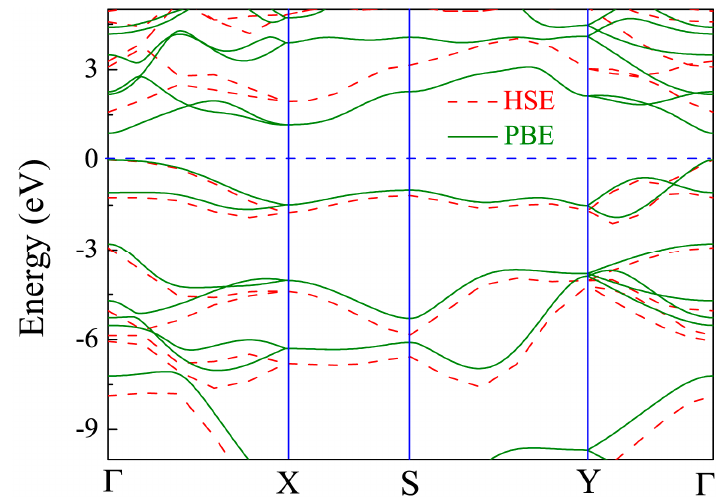
Figure 4. Band structure of pristine monolayer CSe. Solid line is from density functional theory (DFT)–Perdew-Burke-Ernzerhof (PBE) scheme, and dashed line from Heyd-Scuseria-Ernzerhof (HSE06). The Fermi level is set at zero.